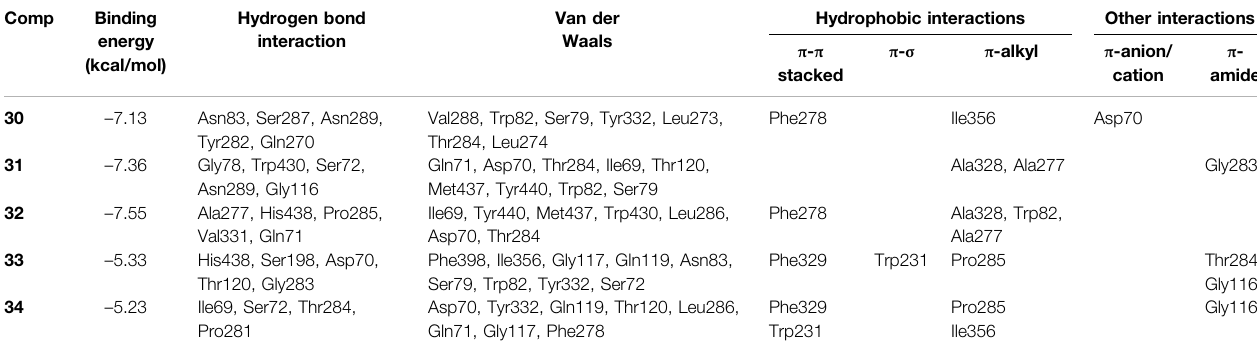
TABLE 2 | Binding site residues and docking scores of compounds 30 – 34 bound to BuChE obtained using Autodock 4.2. Comp Binding